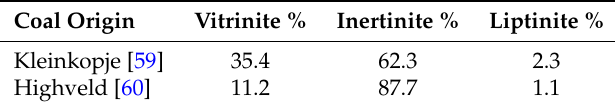
Table 2. Maceral composition (volume % mmf